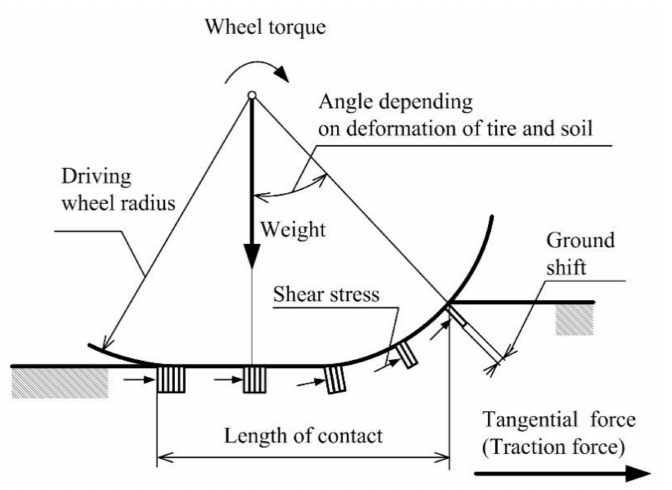
Figure 1. The elastic tire of a driving wheel on soil. The frequency spectrum is typical for the design of wheels and the ground type. The amplitude and specific frequency of vibrations generated by the driving wheels affect the quality of the machine’s operation. Improvement of the driving wheels design of wheeled robots is aimed at reduction of vibrations negatively affecting the robot stability